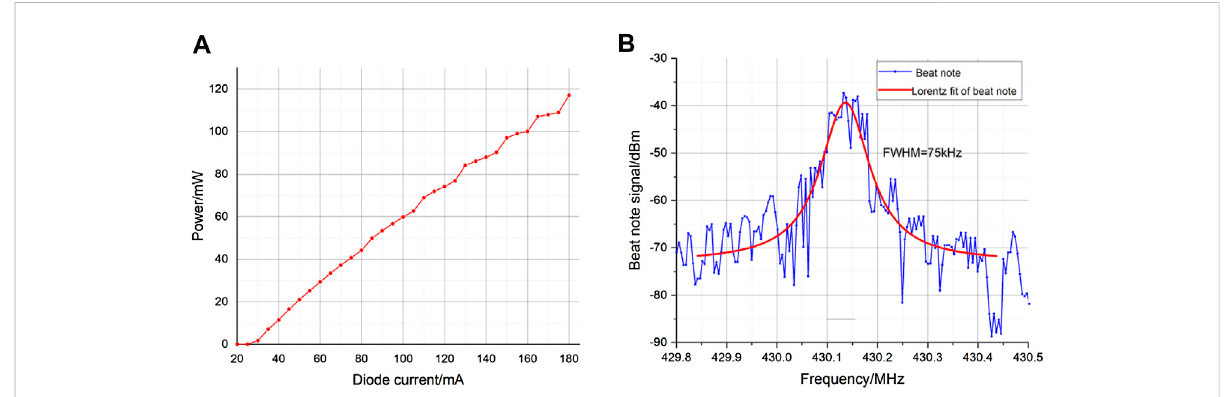
FIGURE 13 The characteristicof theIF-ECDL (A) theoutput laser power versus thediode current (B) thefrequency beat-note signal with another IF-ECDL.